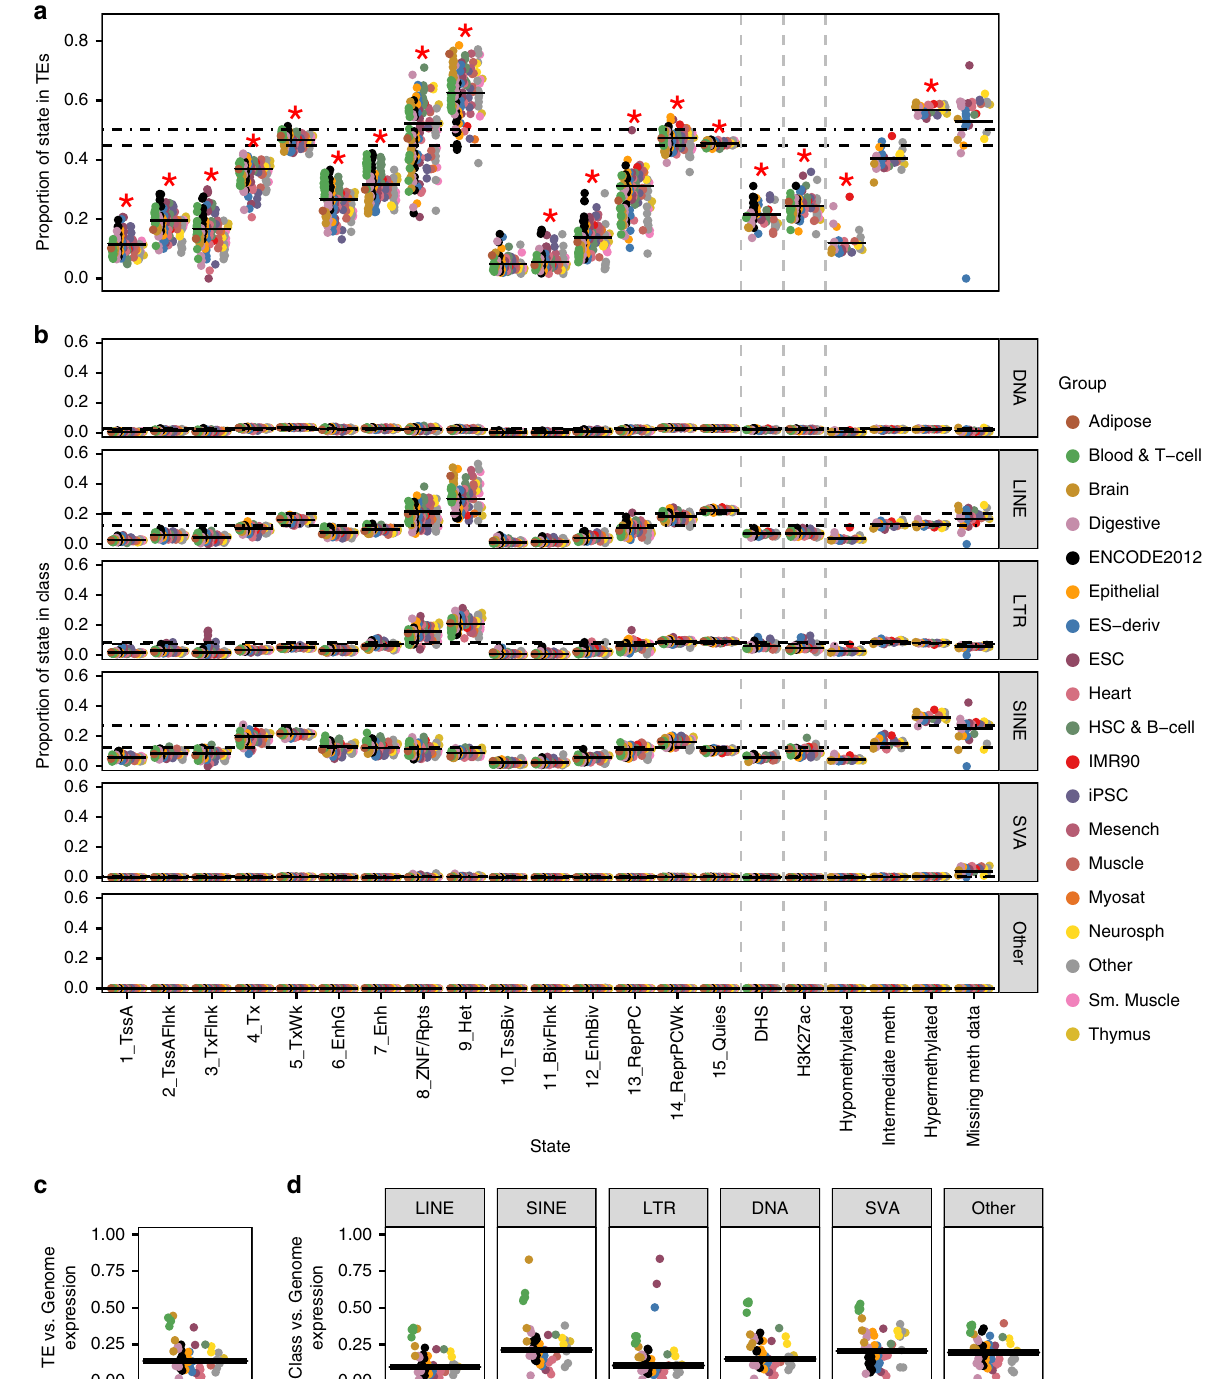
Fig. 4 Variation in TE contribution to epigenetic states by epigenome classi fi cation. a Proportion of the epigenetic state within TEs by epigenome. Each epigenome is represented by a circle, colored by Roadmap group. Solid black lines represent the proportion of the epigenetic state within TEs across all epigenomes (contribution; see Fig. 1c). Dashed and dot-dashed lines represent the proportion of genomic bases and CpGs within TEs, respectively. Red stars represent Bonferroni-corrected Kruskal – Wallis test P -value < 0.05 across epigenome groups (chromHMM states n = 127 epigenomes, methylation states n = 37, DHS n = 53, H3K27ac n = 98; see Supplementary Data 3 for group assignments). b Proportion of the epigenetic state within each TE class by epigenome, colored by Roadmap groups. Solid black lines represent the proportion of the epigenetic state within the class across all epigenomes. Dashed and dot-dashed lines represent the proportion of genomic bases and CpGs within the TE class, respectively. c The ratio of the average RPKM over TEs to the average RPKM over the entire genome, colored by Roadmap group. d The ratio of the average RPKM over each TE class to the average RPKM over the entire genome, colored by Roadmap group. c, d The solid black bar is the median for all epigenomes ( n = 56 epigenomes with RNA-seq